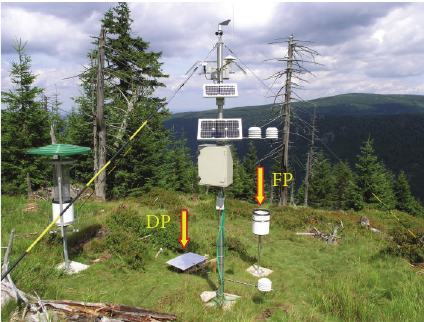
Figure 3: Meteorological station Smˇedava, Jizersk´e hory Mts. (DP: instrument for the deposited precipitation measurement, i.e., dew gauge; FP: instrument for the falling precipitation measurement, i.e., tipping bucket rain